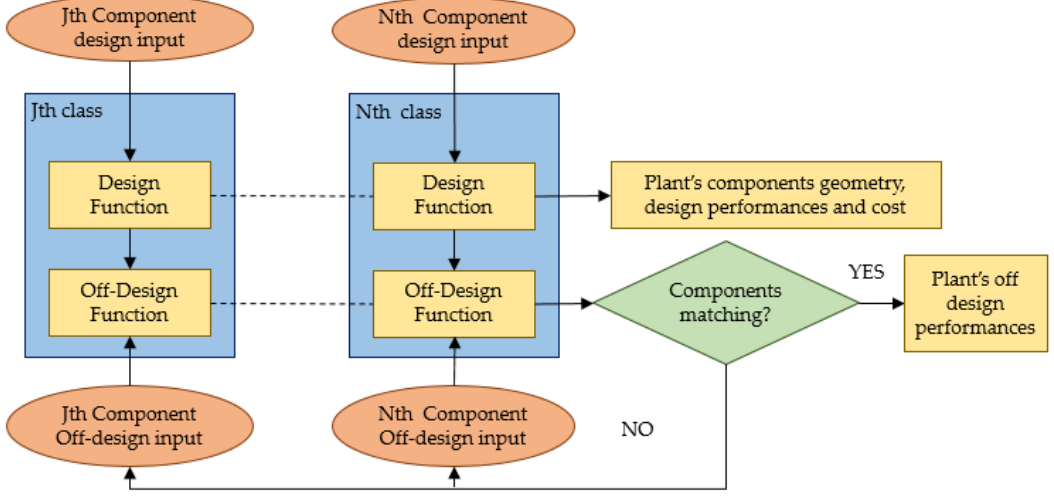
Figure 2. Logic flowchart of the code.